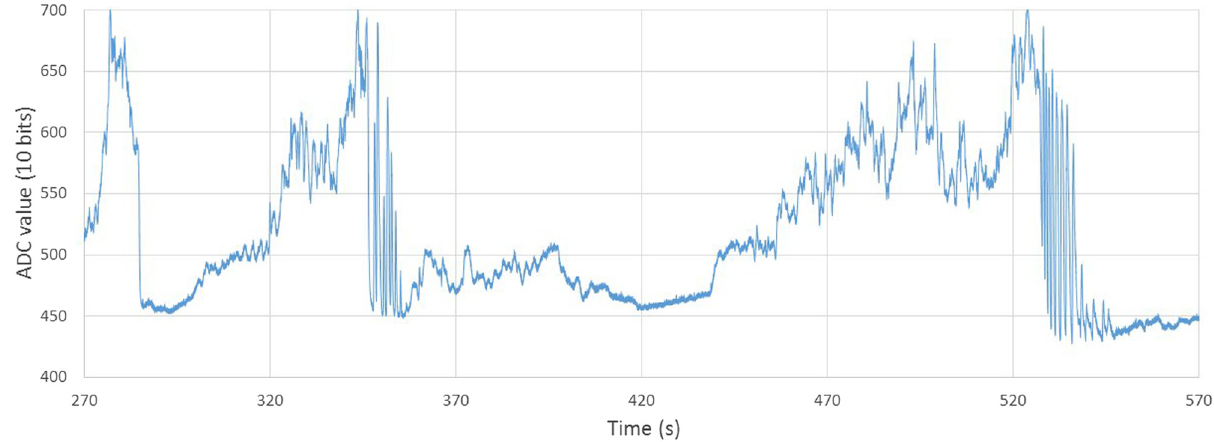
Figure 21: Pelvic muscle tension during two male multiple